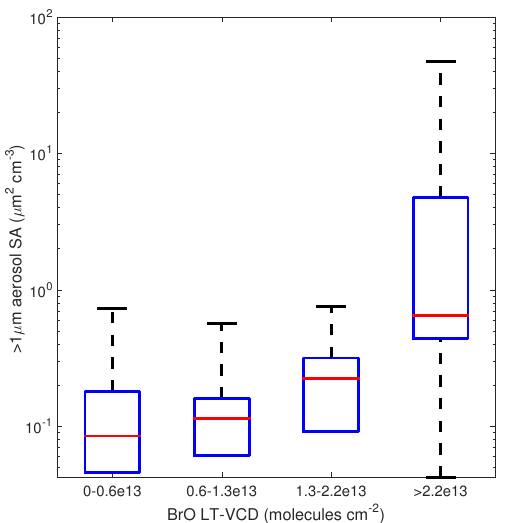
Figure 10. Box and whisker plot of supermicron particle surface area (SA) concentrations as a function of BrO LT-VCD. The red line represents the median, the blue box outlines the inner quartiles, and the whiskers represent the outer quartiles. In some cases, the differ- ence between the lowest aerosol observation and the 25th percentile is too small to draw a lower whisker. These aerosol observations are restricted to altitudes where the plume was observed on takeoff and binned by dividing the BrO observations into